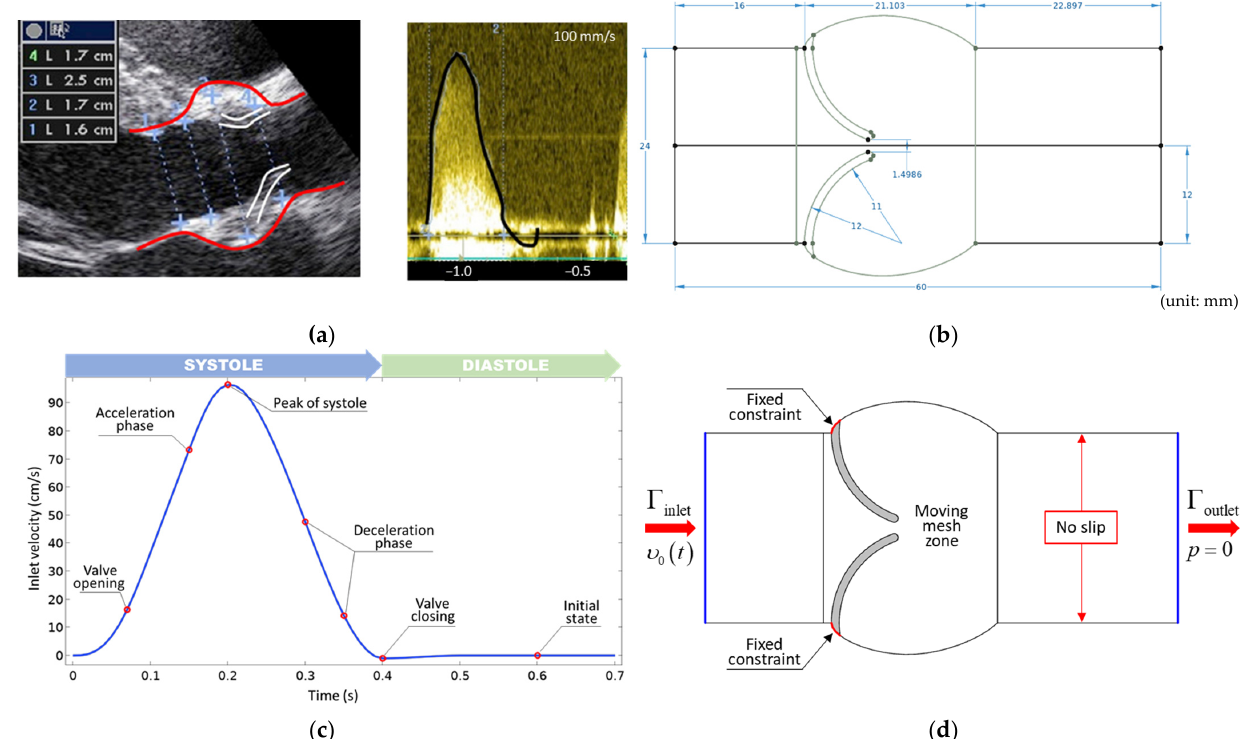
Figure 1. ( a ) B-mode views are used to determine aortic valve dimensions and the time-dependent inlet velocity profile measured via pulsed Doppler mode [44]. ( b ) Idealized 2D geometry with dimensions (unit: mm). ( c ) Velocity profile applied at the inlet boundary. ( d ) Boundary conditions.